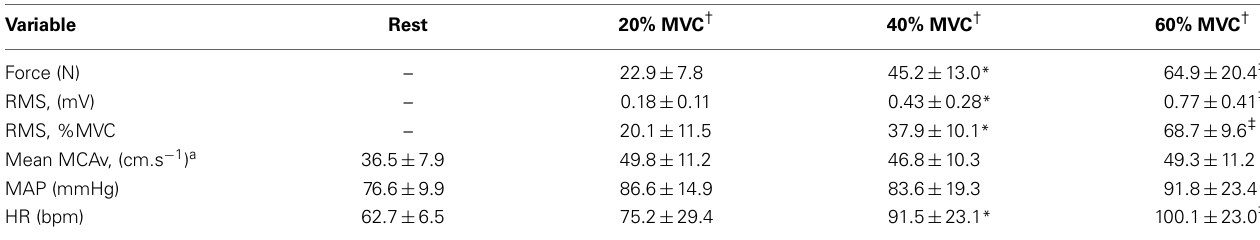
Table 1 | Electromyographic, cardiovascular and cerebrovascular responses at rest and during 24 intermittent isometric contractions of the biceps brachii at three intensities (Values are mean ± SD , N = 11).